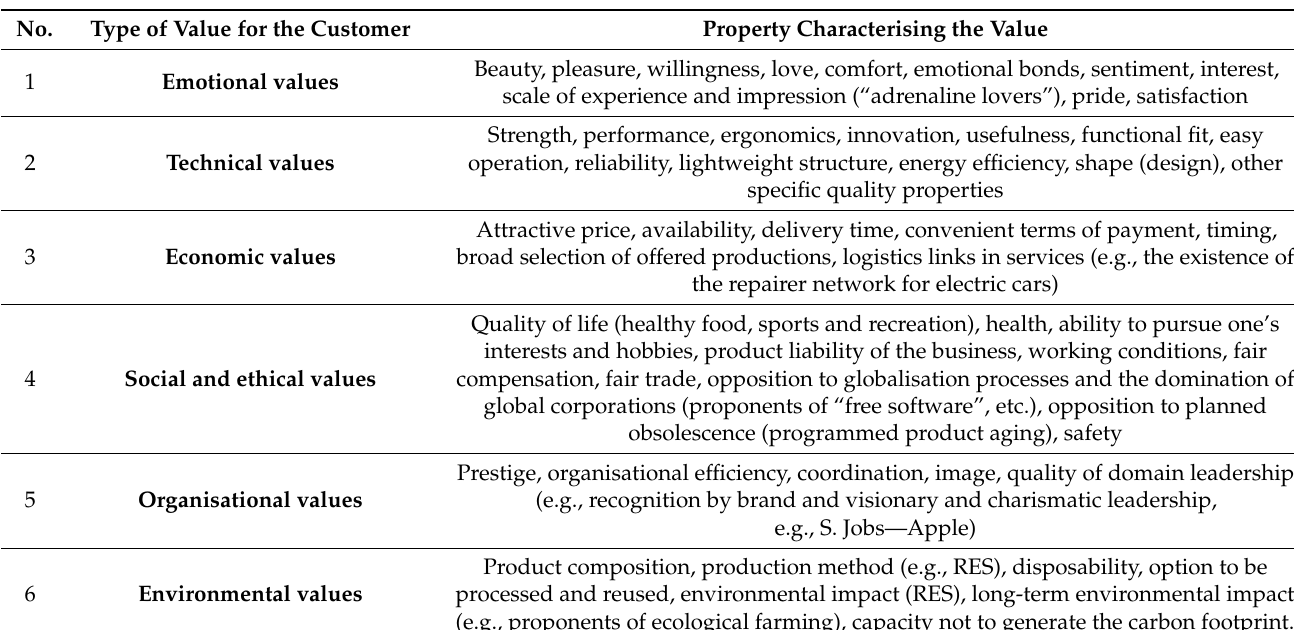
Table 3. Properties of value created for customer by business